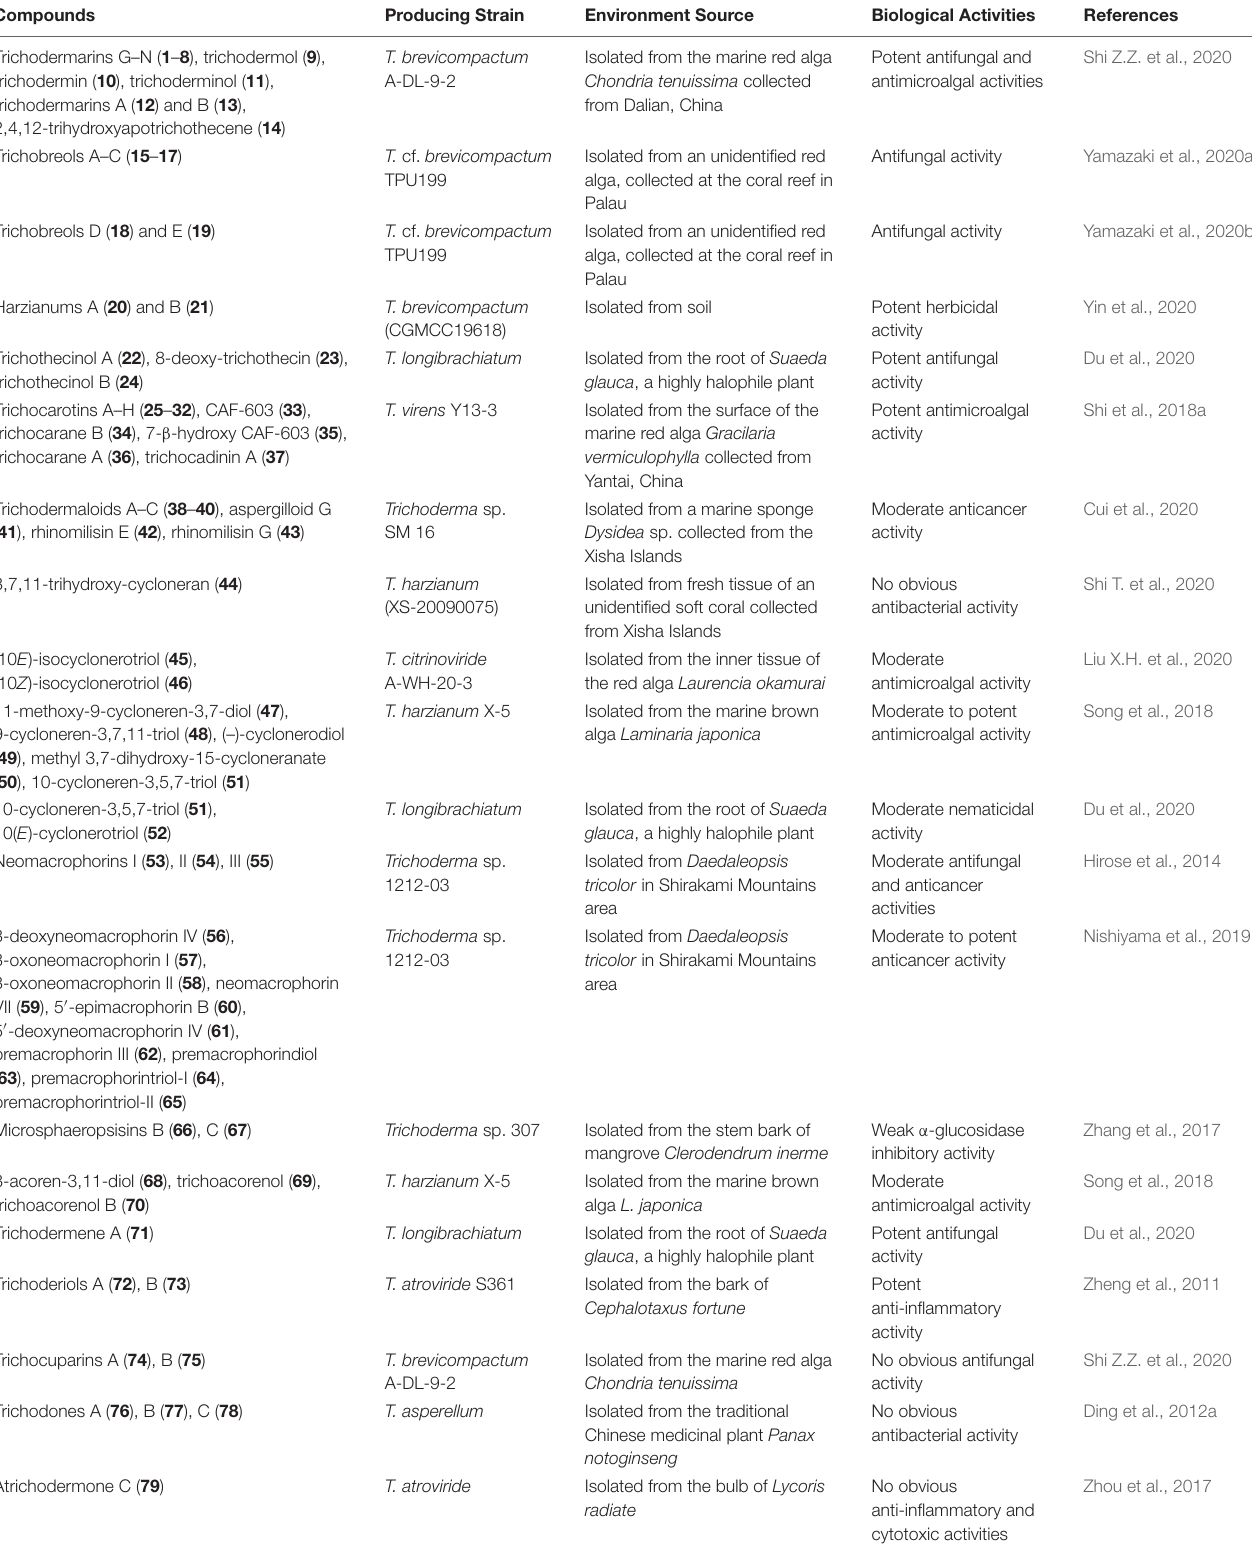
TABLE 1 | The producing strain, environmental source, and biological activities of compounds 1 – 203